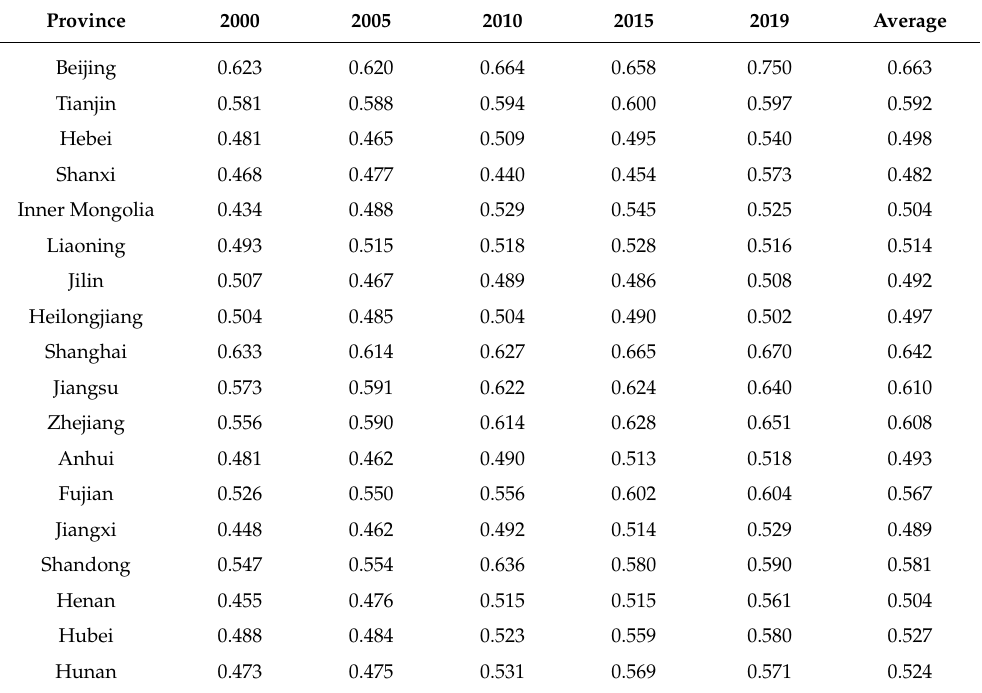
Table 4. Coordination degree of the 3E system in